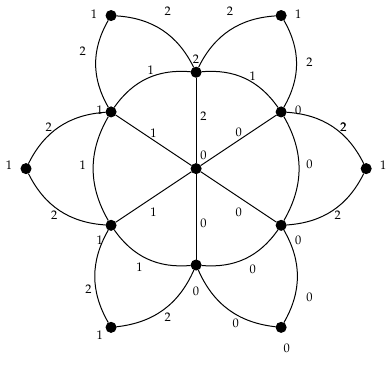
Figure 8. 3-TEPC labeling of Fl